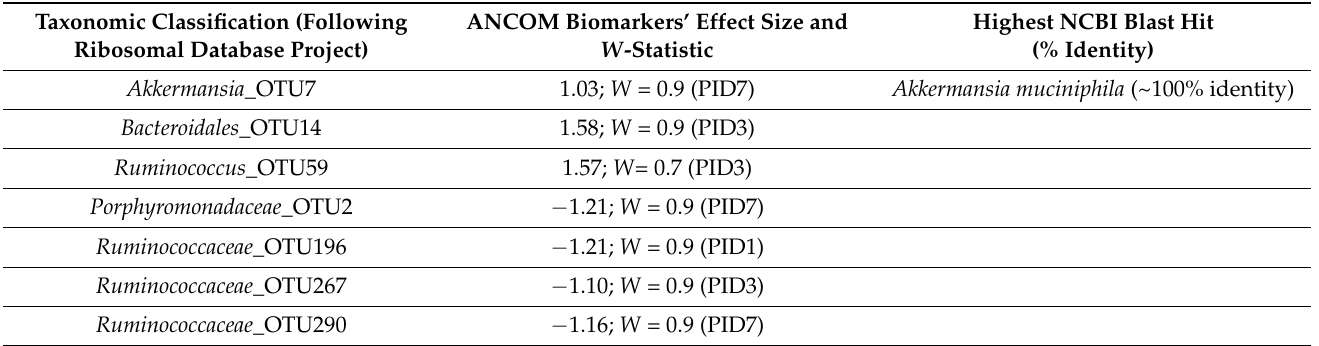
Table 2. Differential operational taxonomic units (OTUs) detected in L. indica PCC 8005-given mice following pelvic irradiation. PID = post-irradiation day.